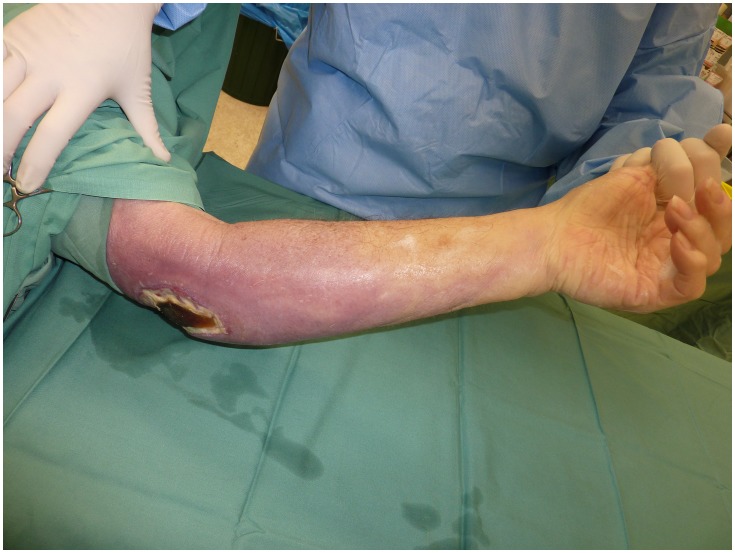
Oedematous M. ulcerans lesion of left elbow region showing necrosis.